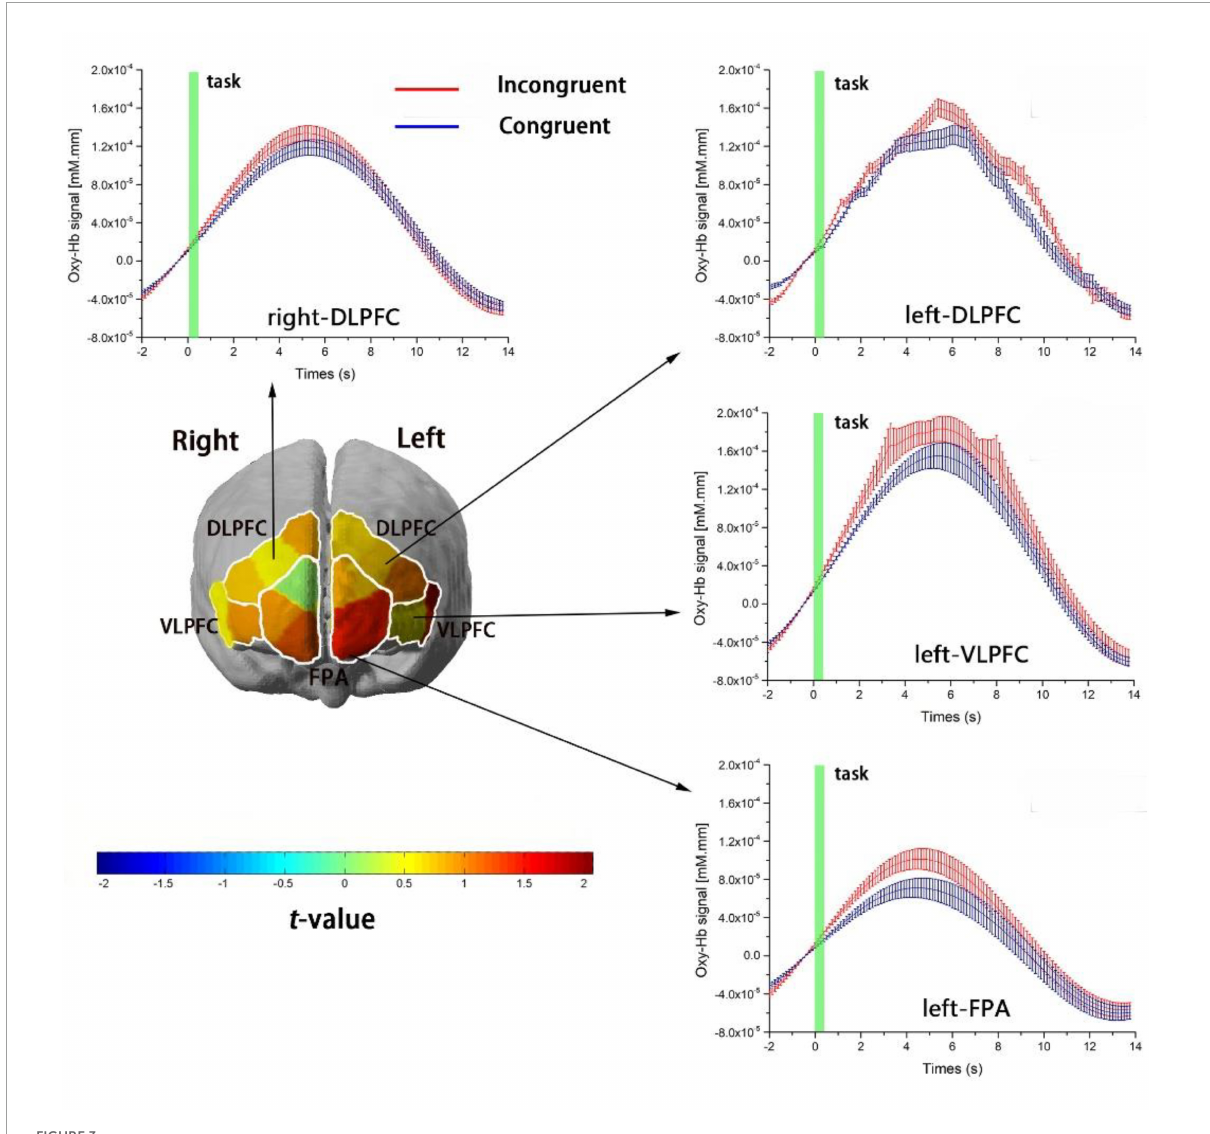
FIGURE3 Cortical-activation patterns involving the Stroop task. The four graphs show the timelines for Oxy-Hb signals as responses to the incongruent (red) and congruent (blue) tasks in the left DLPFC, right DLPFC, left VLPFC, and left FPA. The timelines are adjusted to the average value at baseline (i.e., 2 s before task onset). Changes in Oxy-Hb signals are presented in arbitrary units (mM mm). Error bars represent the standard error at various time points. The left figure is a t-map of changes in the Oxy-Hb signal that reflect the effect of Stroop interference (incongruent–congruent); t -values are presented using the color